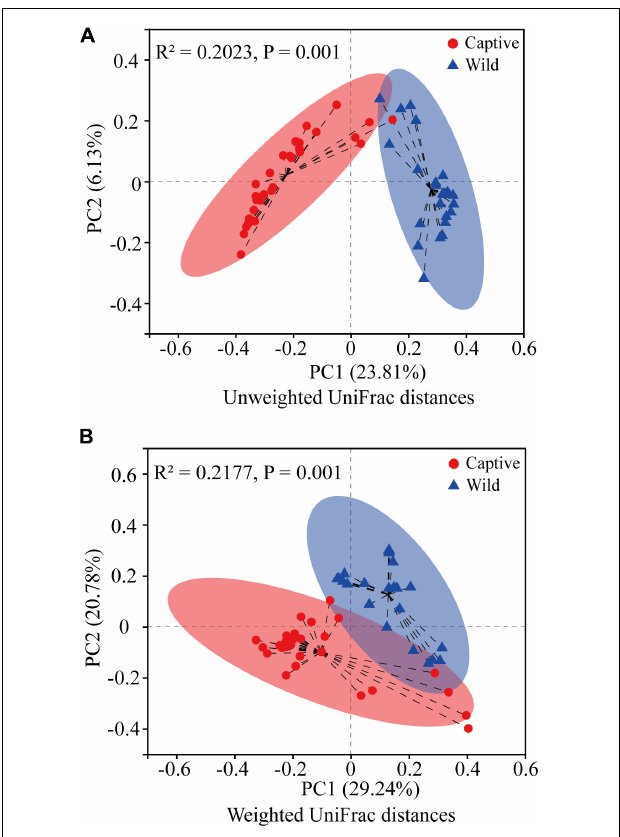
FIGURE 3 | Difference in gut microbiota community structure between captive and wild geckos using Adonis test (permutation = 999). (A) A principal coordinate analysis of unweighted UniFrac distances; (B) A principal coordinate analysis of weighted UniFrac distances.